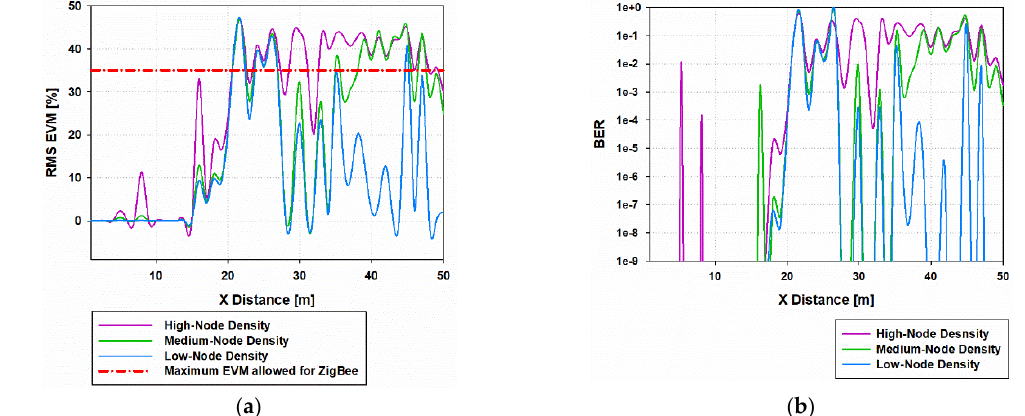
Figure 13. ( a ) Linear distribution line of EVM (%) for Y = 5 m, X-axis in the considered scenario when outdoor node is transmitting, ( b ) Linear distribution line of bit error rate for Y = 5 m, X-axis in the considered scenario when outdoor node is transmitting.